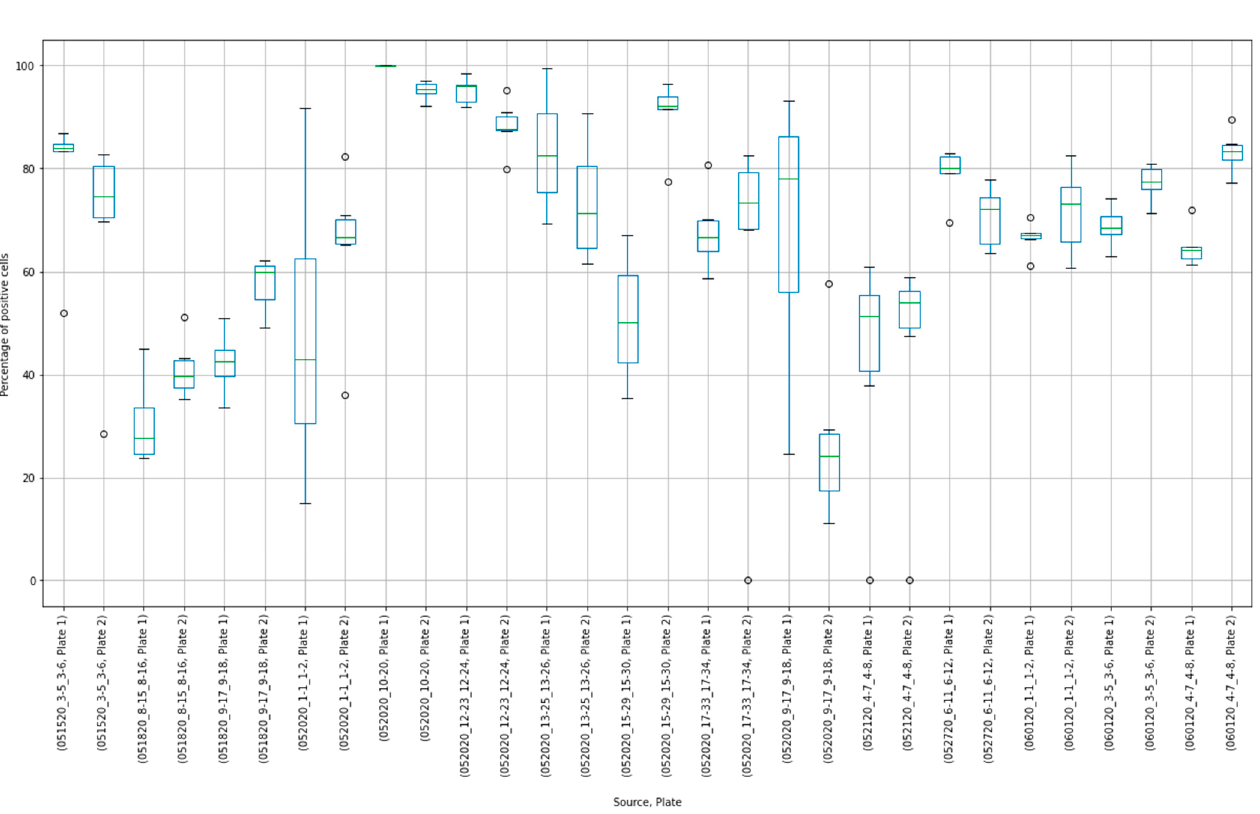
Figure 3. Box plot results of virus control observations.